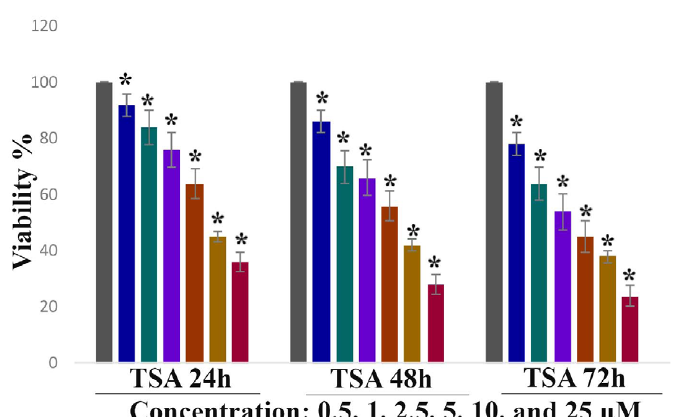
FIGURE 1 – Effect of TSA on WCH 17 cells viability determined by MTT assay. Data are presented as mean ± standard deviation from triplicate wells and three independent experiments. Asterisks (*) indicate significant differences between treated cells and the control group. The first column of each group belongs to the control group.